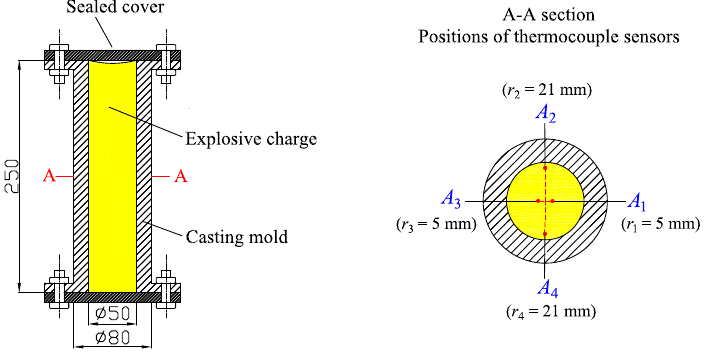
Figure 1. Schematic of experimental